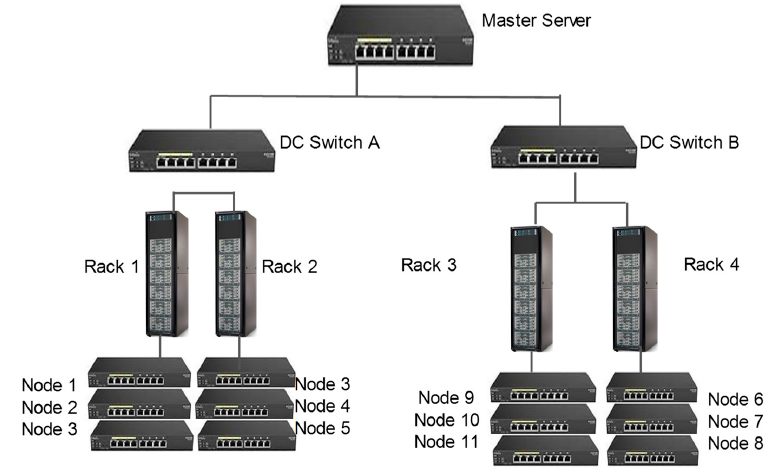
Figure 5. The primary component of Hadoop cluster.